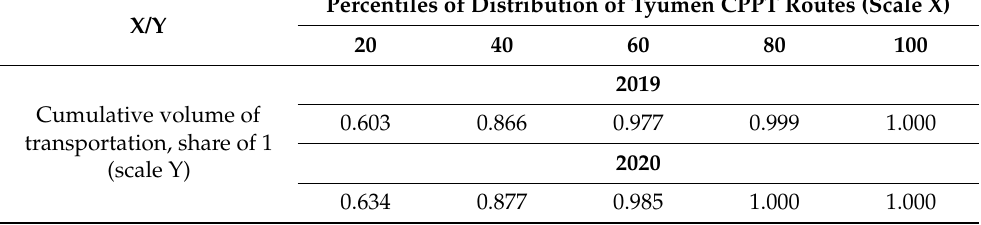
Table 12. Characteristics of cumulative curve (Lorenz curve) of distribution of transportation volume Q 04 at Tyumen CPPT routes.